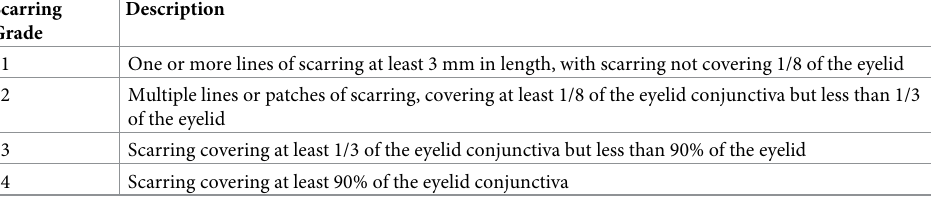
Table 1. Trachomatous scarring grading